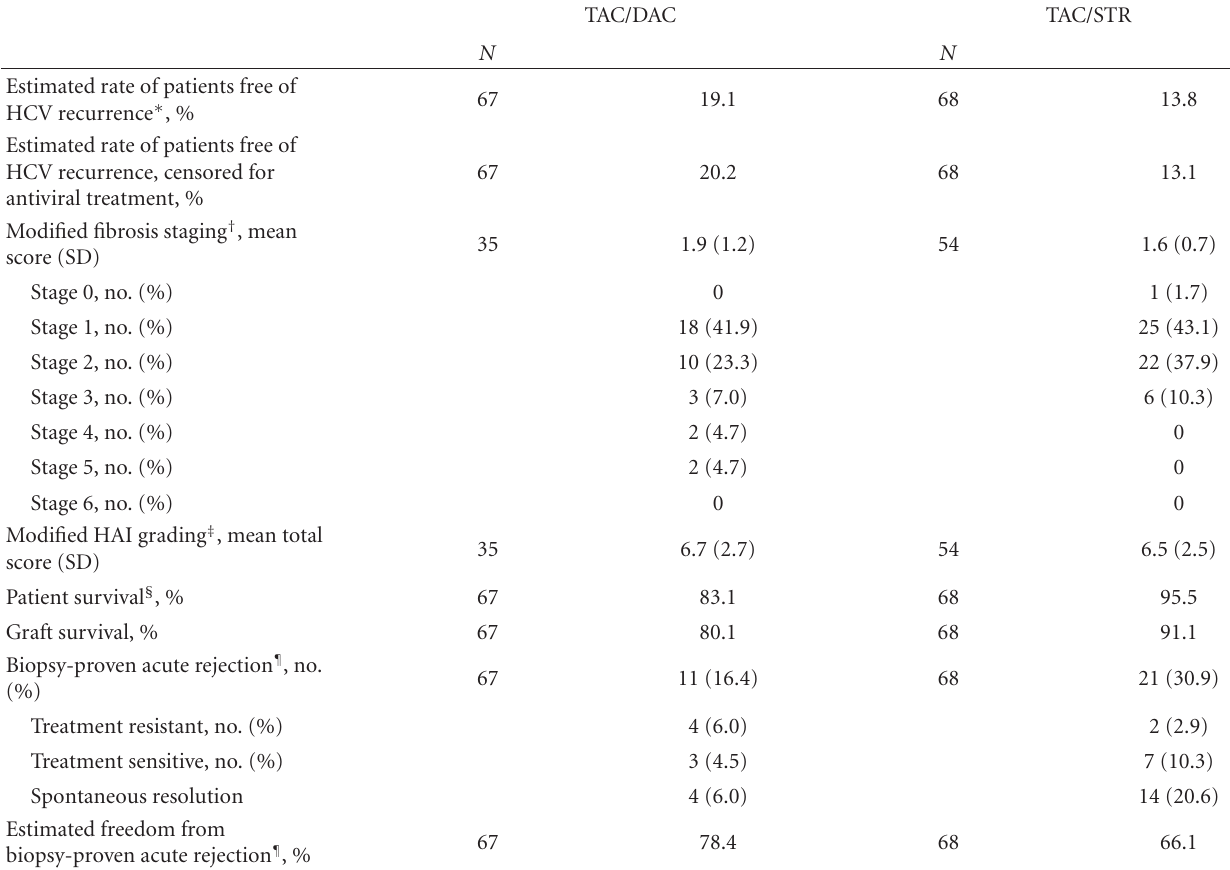
Table 3: Secondary study endpoints-full analysis